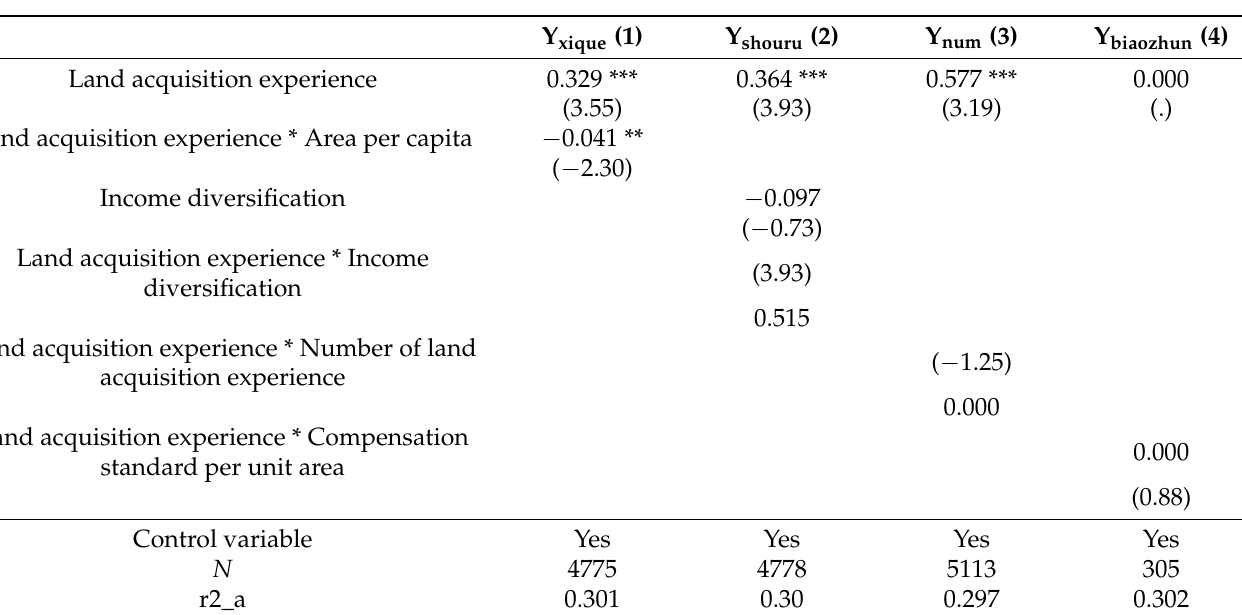
Table 8. Verification results of mechanism of